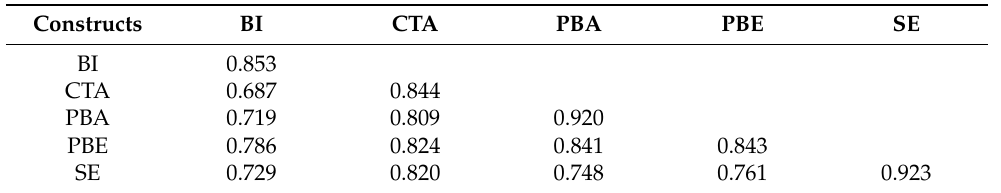
Table 2. Discriminant Validity (Fornell–Larcker